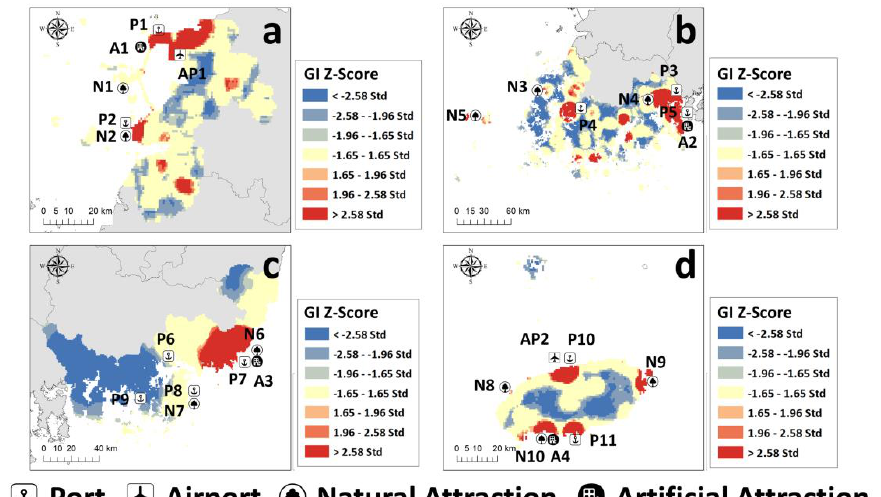
Figure 6. Coastal tourism hotspots at regional level: ( a ) Jeollabuk-do; ( b ) Jellanam-do; ( c ) Gyeongsangnam-do; ( d ) Jeju-do (Gi Z-score and the names of each facility and tourist attraction are referred to Appendix D).